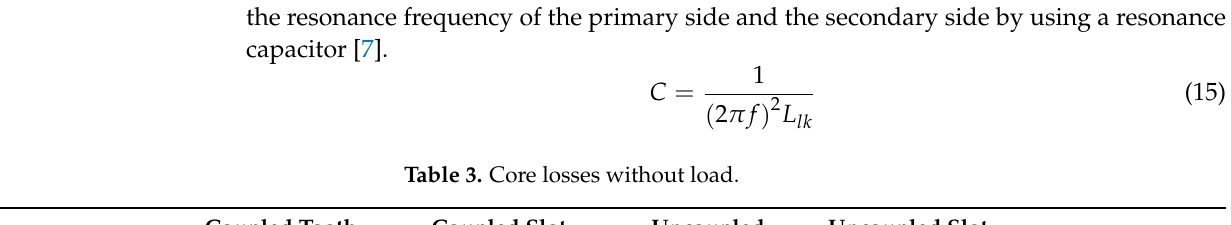
Table 4. Core losses with load.